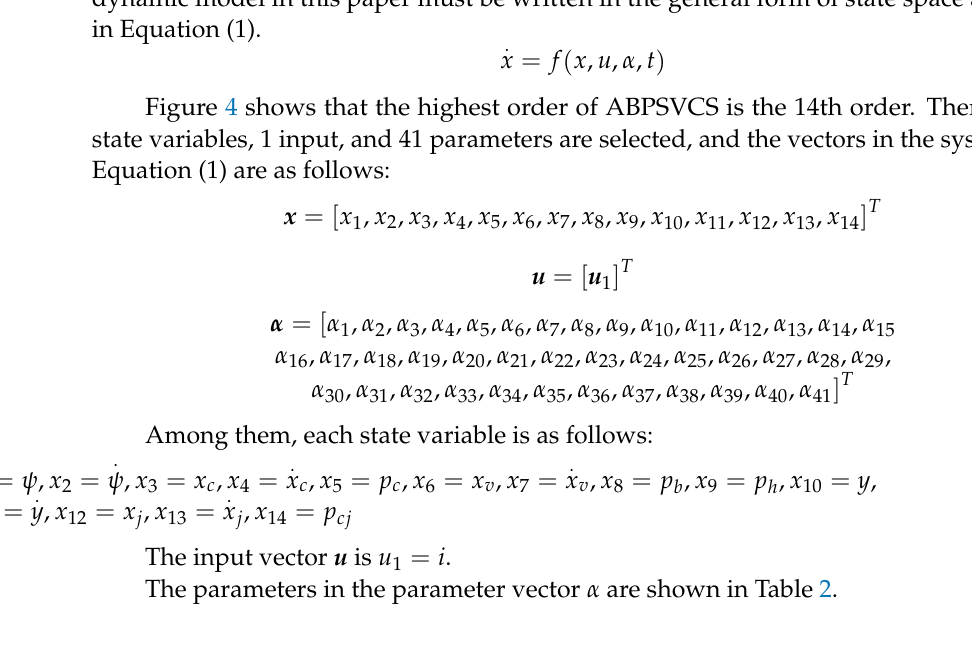
Figure 4. ( a ) Block diagram of ABPSVCS. ( b ) Flow block diagram of ABPSVCS. ( c ) Logical block diagram of hydraulic system.